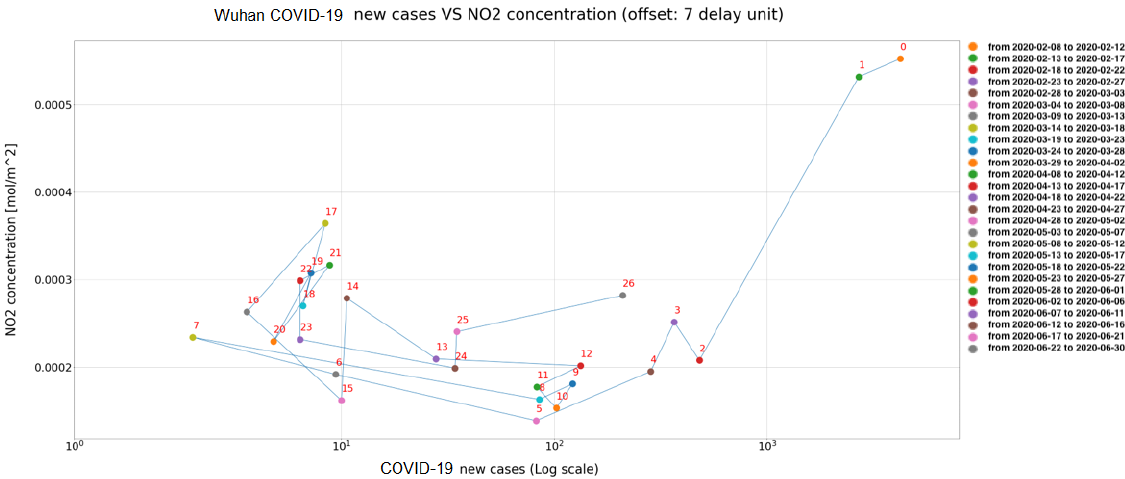
Figure 16. New daily cases vs. average concentration of NO 2 in